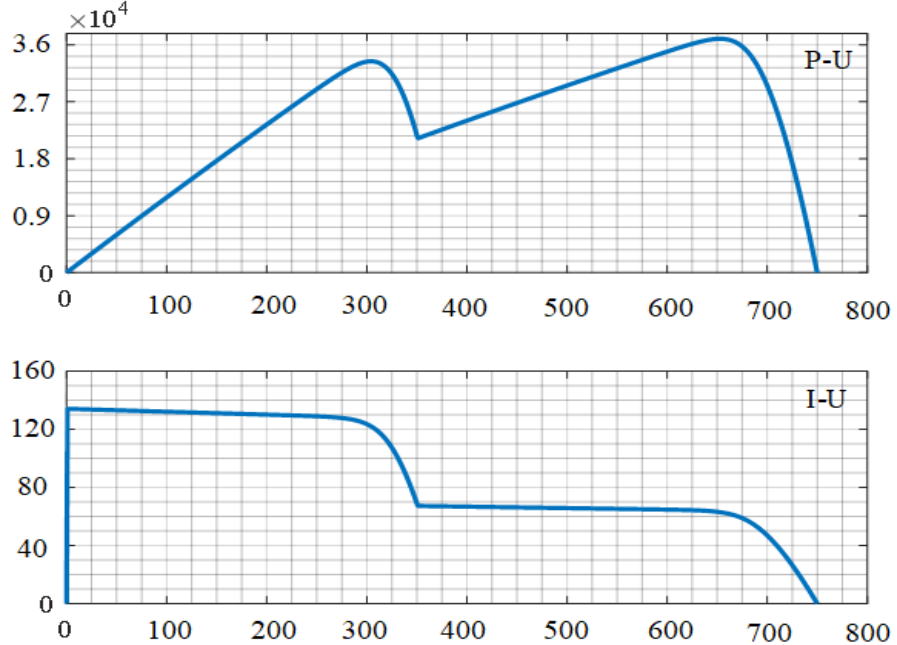
Figure 13. P-U and I-U characteristic curves. Table 4. Parameters related to the photovoltaic cell for the experiment.